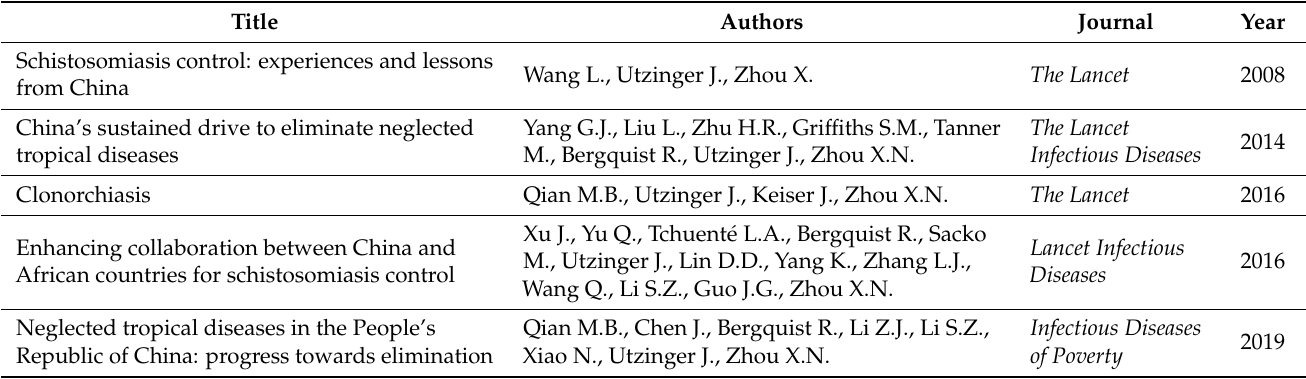
Table 2. High-impact articles on parasitic diseases resulting from collaborative research between NIPD and Swiss